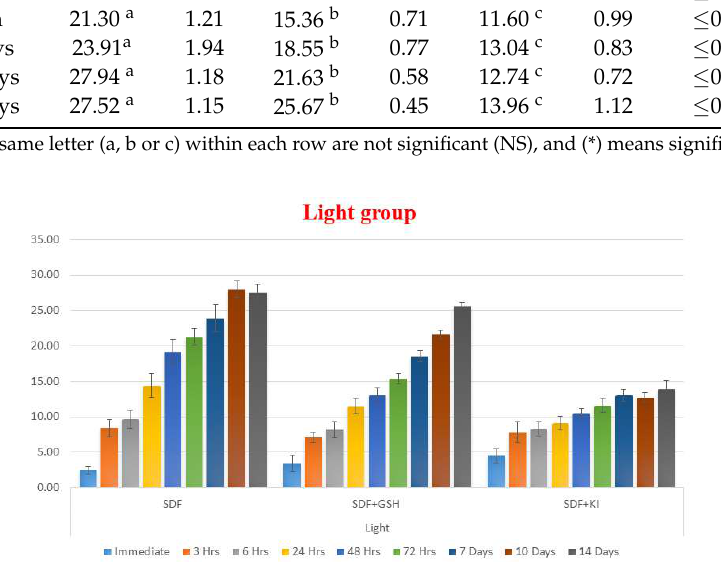
Figure 3. Bar chart showing mean ΔE for different tested groups for dentin substrate within each time interval under light exposed conditions.